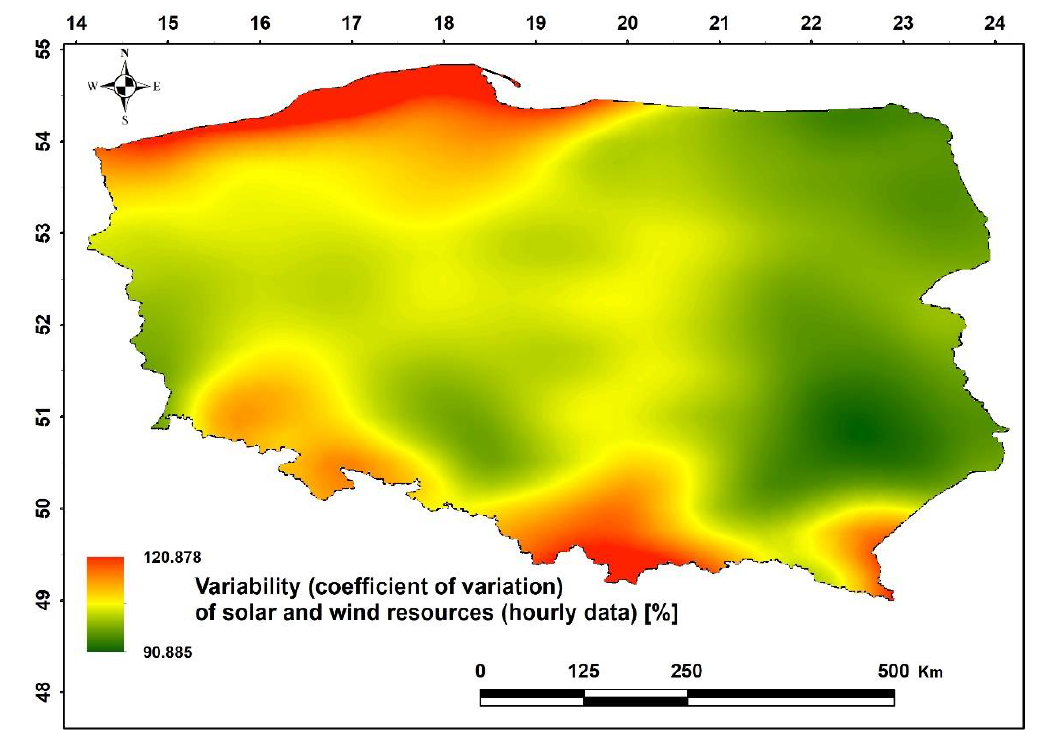
Figure 13. Solar+wind resources coefficient of variation, 1980 – 2019.